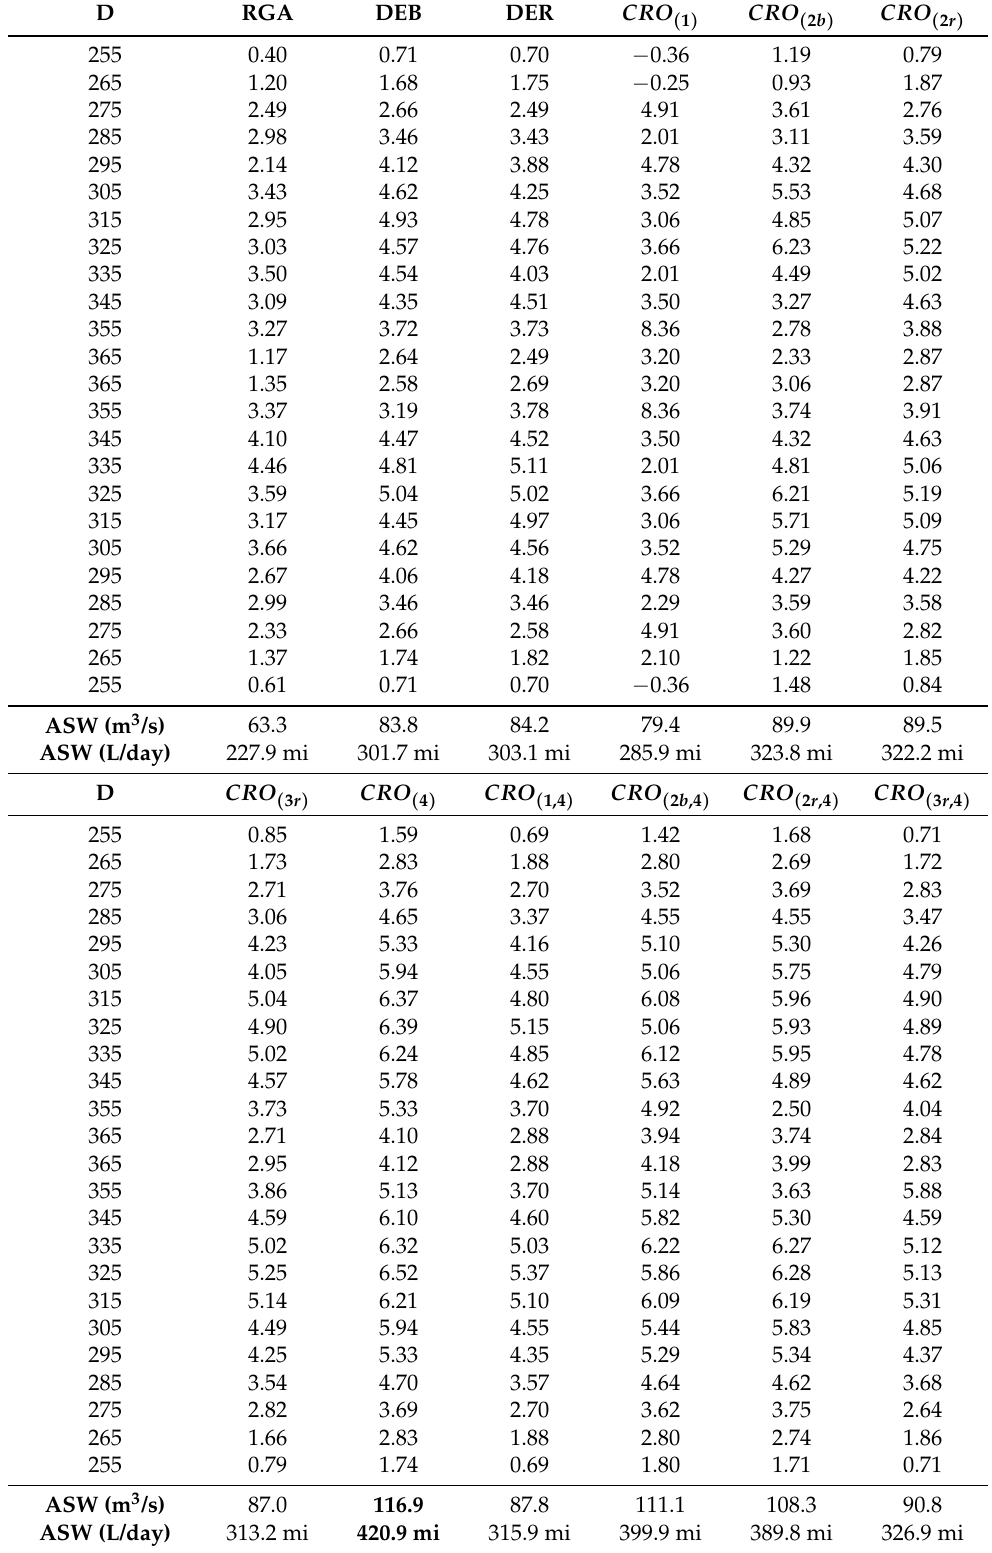
Table 2. Water saved in daily (d) power production. Million liters (mi). In bold the best results